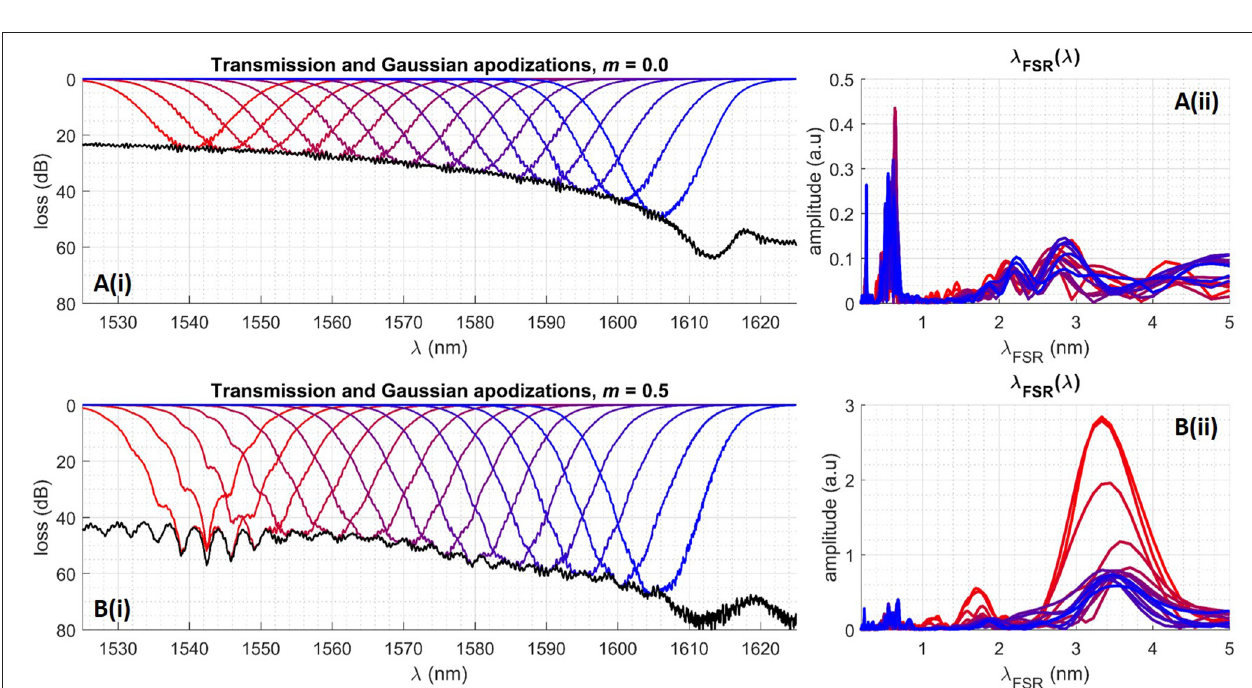
FIGURE 7 | Transmission spectra for 250 µ m long horizontal-slot fin-waveguides ( 3 = 450 nm, fill-factor = 0.5) at a range of mismatch ( m ) parameters, demonstrating PBG width decreasing linearly as m → 0.5. Inset shows measured PBG width as a function of m .